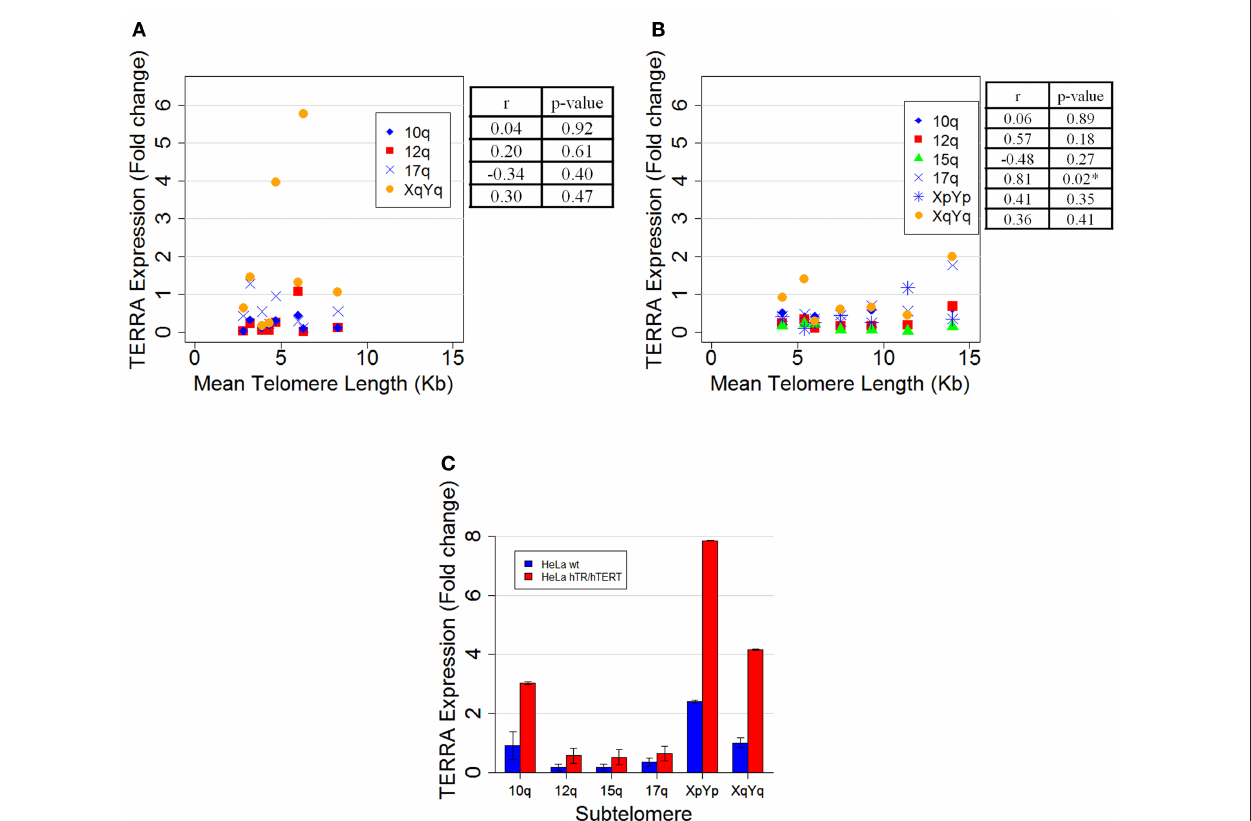
primer pairs described in (A) , a pair specific for the 15q subtelomere (green triangles) and a pair specific for XpYp (blue asterisks). Pearson’s correlation coefficient ( r ) and its significativity ( p -value) for each primer pair are shown on the right. A significant r coefficient ( * p < 0.05) was calculated for the 17q primer pair, suggesting that, at some of the chromosome ends recognized by these sequences, telomere length, and TERRA expression may be positively correlated. (C) Subtelomere-specific TERRA levels in HeLa wild type (blue bars) and HeLa hTR/hTERT cells (red bars) determined by qRT-PCR. The value of the subtelomere XqYq from HeLa wild type was set at 1. Averages and standard deviations from two experiments are shown. Each reaction was carried out in